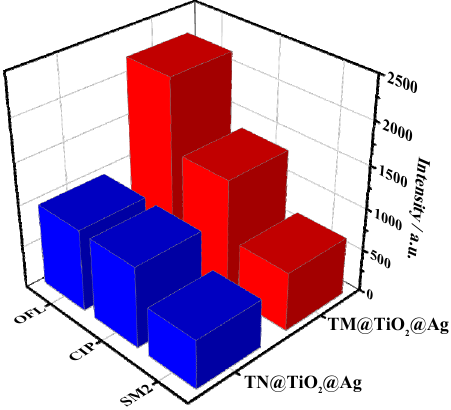
Figure 5. Photocatalytic degradation property of AgNPs, TiO 2 , TiO 2 @Ag, and TM@TiO 2 @Ag for OFL.